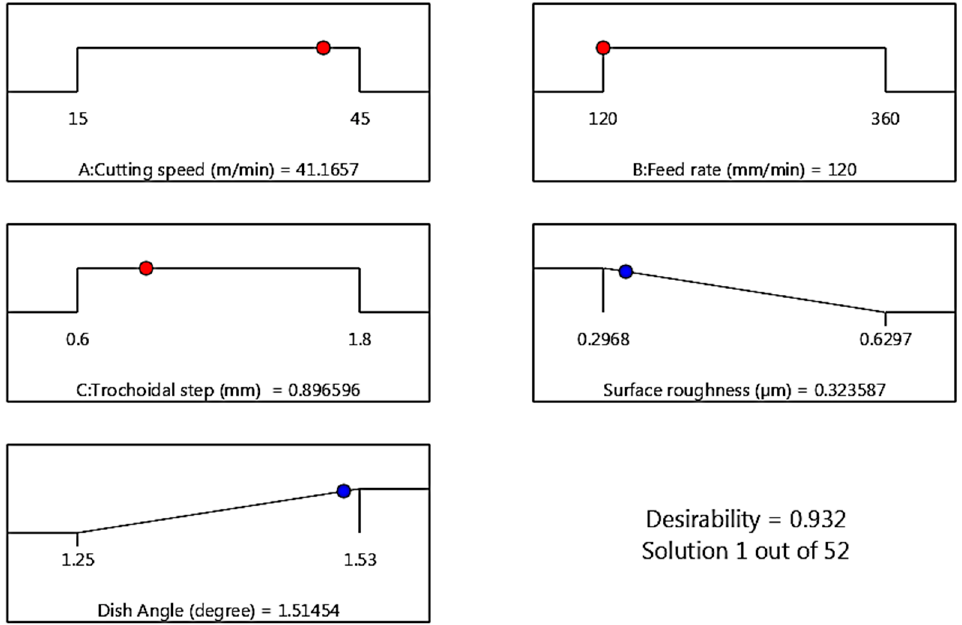
Figure 11. Effect of trochoidal step on dish angle (Tool wear) using Vision measuring system (corresponding to run numbers in Table 4).